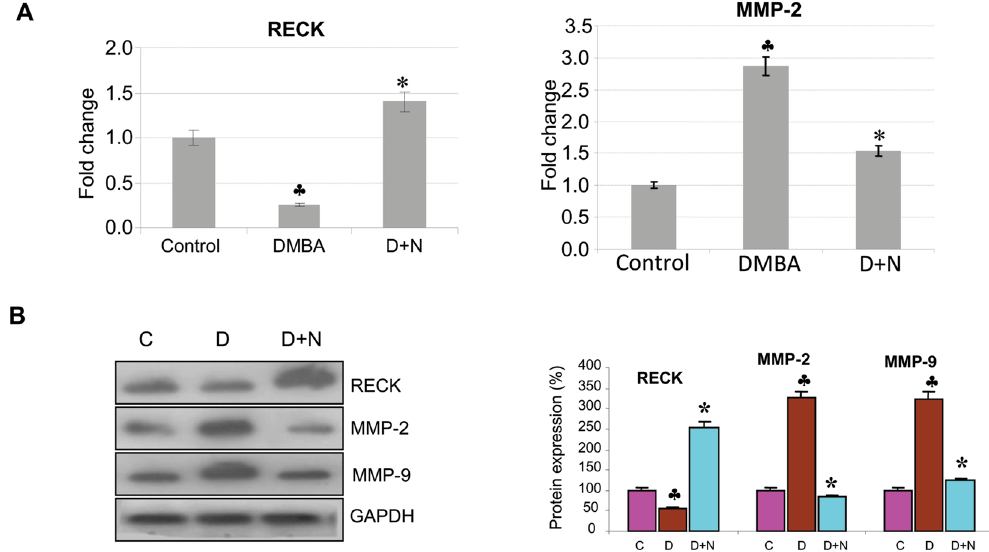
Figure 4. Nimbolide upregulates RECK expression. ( A ) qPCR analysis shows that RECK is upregulated, and MMP-2 was downregulated after nimbolide treatment (N = 3). ( B ) Immunoblotting was performed to analyse the expression of RECK, MMP-2 and MMP-9. Data are the mean ± SD of three independent experiments (N = 3). ♣ p < 0.001 versus control. * p < 0.001versus DMBA. D + N indicates DMBA +